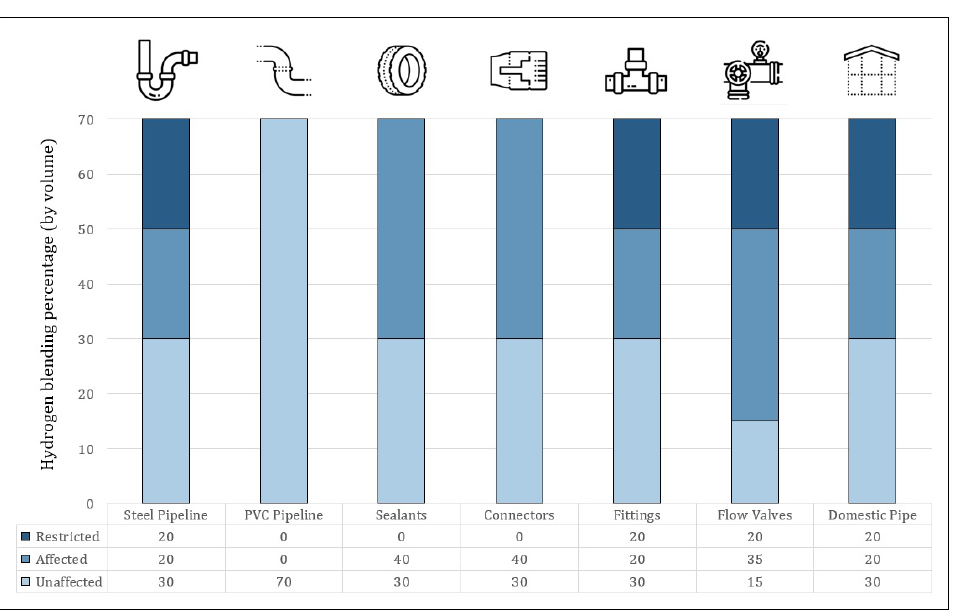
Figure 9. Susceptibility of P2G distribution elements to different volumes of hydrogen blending.